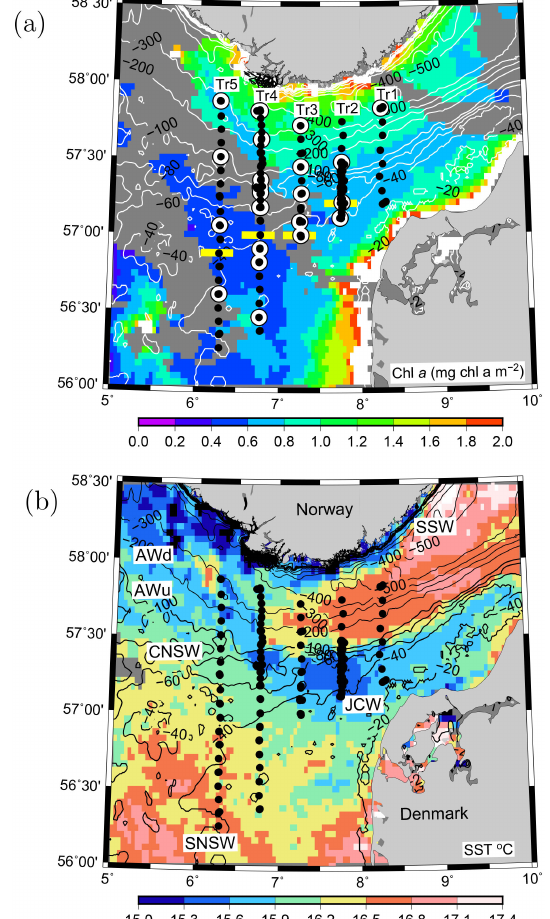
Figure 1. VERMIX station map of the five transects in the northeastern North Sea overlaid on (a) surface chlorophyll a (mgchlm − 3 ) and (b) sea surface temperature ( ◦ C) from MODIS satellite images (4km resolution) obtained on 20 July 2016 (clouds are shown in dark grey). (a) CTD stations (bullets) and stations where 14 C incubations for primary production were used for es- timating photosynthetic parameters in the area (white circles) along the five transects (Tr1–5). Horizontal yellow bars (Tr2–5) show the separation between nitrate-deplete and nitrate-replete areas. Water masses in the area are indicated (see text). Bathymetry is contoured in